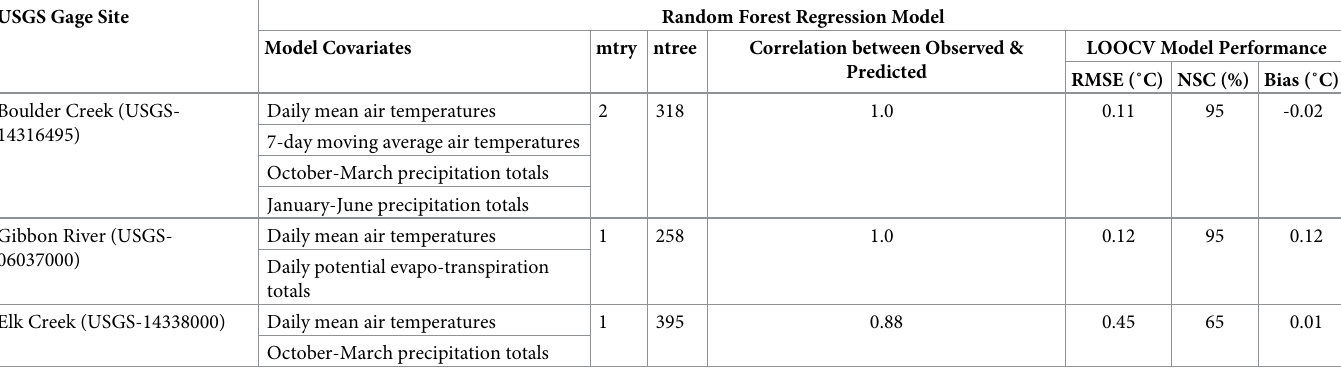
Table 7. Fitness, structure, and performance of best fit random forest regression models for the winter mean water temperatures and accumulated degree-days of studied stream sites. USGS Gage